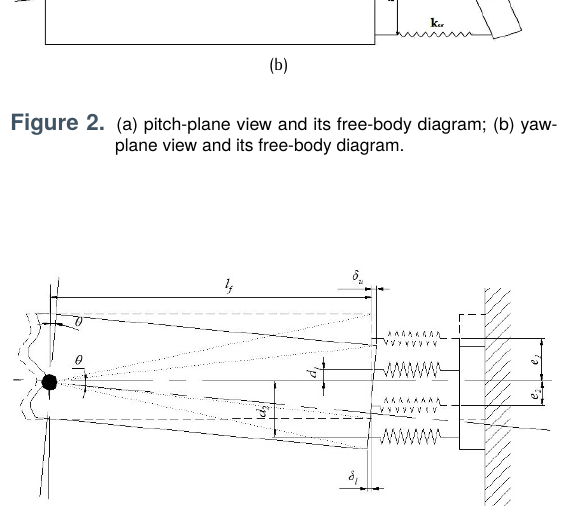
Figure 3. Illustration drawing of the front-end deformation due to vehicle pitching (--- before pitching, — after pitching).